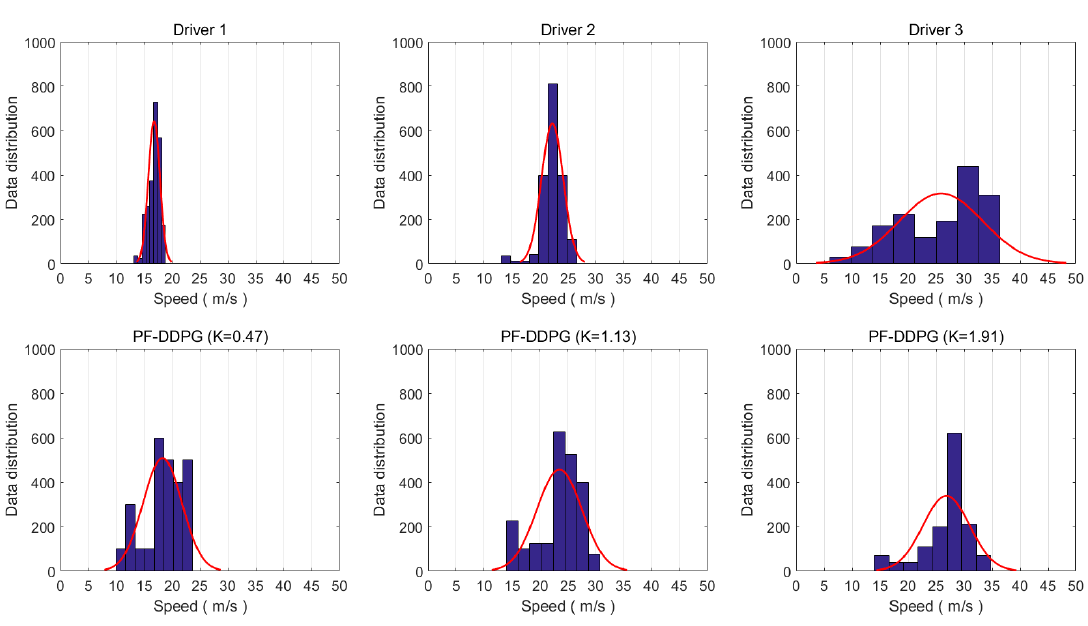
Figure 8. PF-DDPG driving speed distribution compared with drivers.